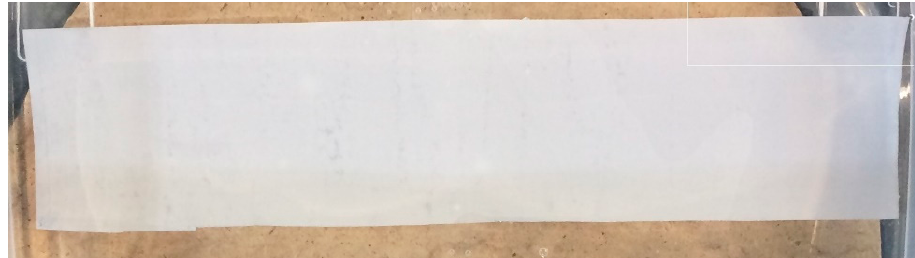
Figure 1. Flat Sheet Membrane.